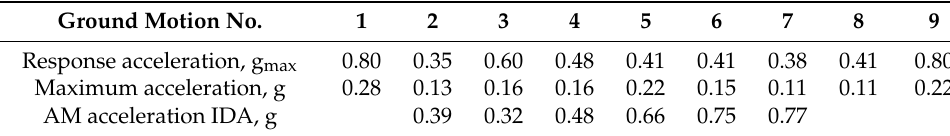
Table 4. Ground motion parameter.